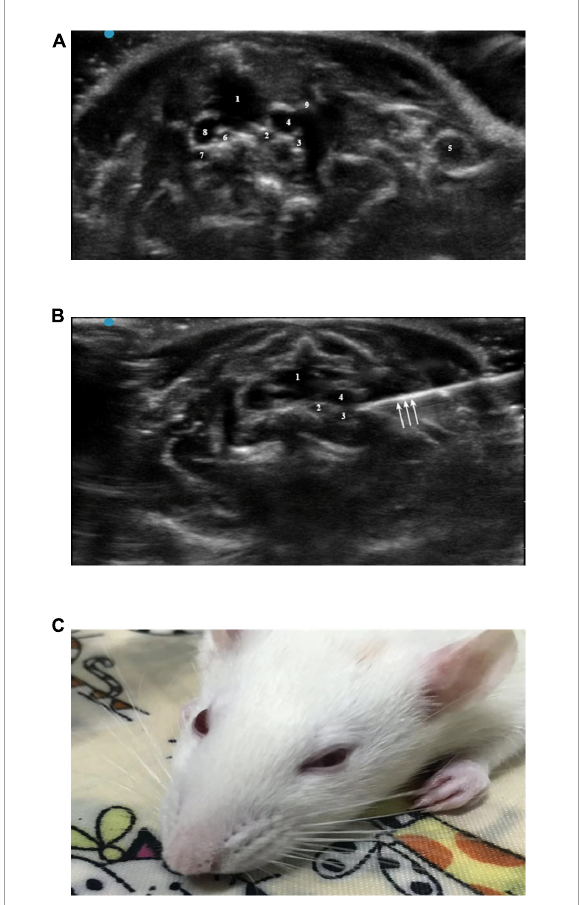
FIGURE2 (A) Horizontal ultrasonography of the first intercostal space: 1, trachea; 2, left common carotid artery; 3, left subclavian artery; 4, left brachial vein; 5, left subclavian vein; 6, right common carotid artery; 7, right subclavian artery; 8, right brachial vein; 9, left first rib. (B) Ultrasound-guided SGB: 1, trachea; 2, left common carotid artery; 3, left subclavian artery; 4, left cephalic brachial vein; arrow, needle. (C) Successful ultrasound-guided left SGB in rats (Horner syndrome).